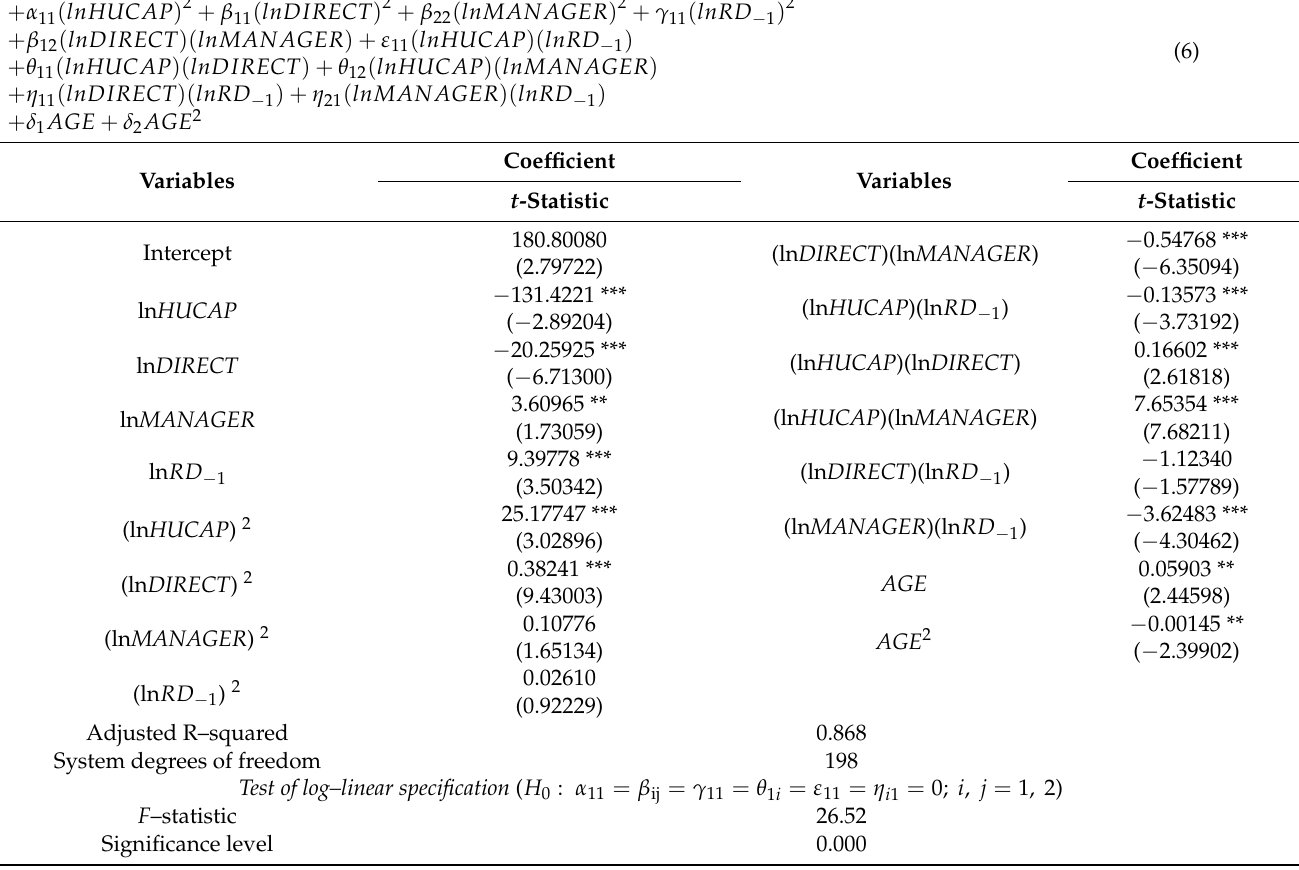
Table 5. Estimation of translog revenue function for data pooled over 2009–2018 (t–statistics in parentheses). lnREVENUE = β 0 + α 1 lnHUCAP + β 1 lnDIRECT + β 2 lnMANAGER + γ 1 lnRD −